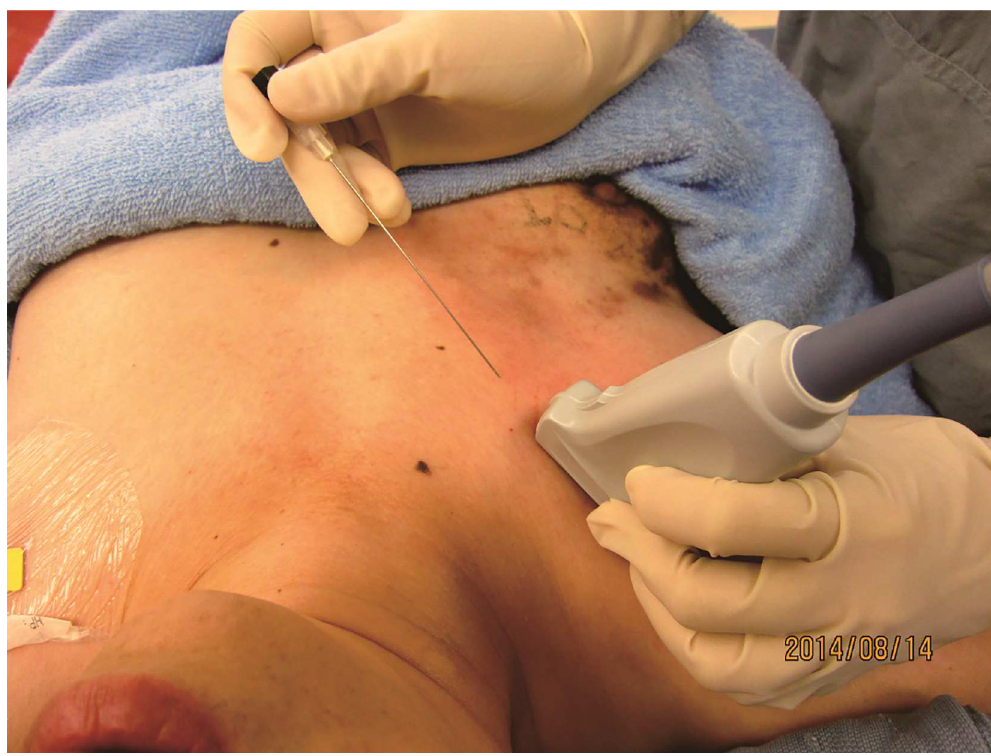
Fig 1. Probe orientation when performing blocks targeting lateral pectoral